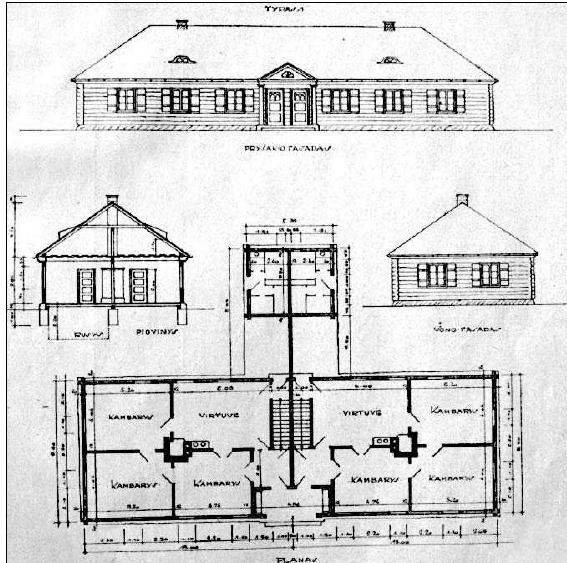
Fig. 2. Project of two-family wooden house for Panemunė neighborhood (arch. E. Pejeris), 1922